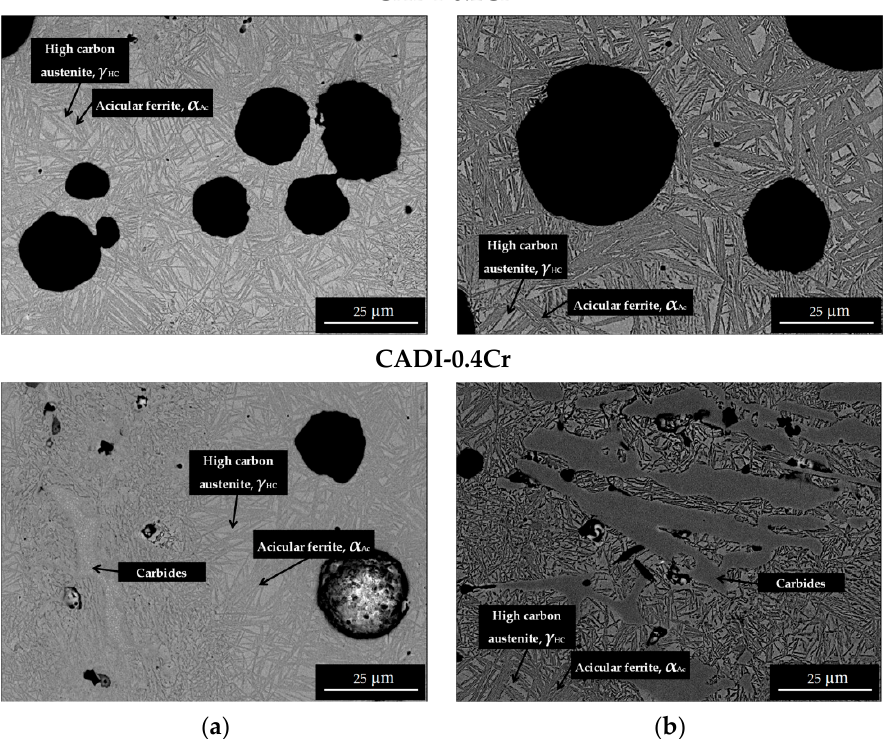
Figure 8. Microstructure of CADI alloyed with 0.2 and 0.4 wt% Cr heat-treated to ( a ) 265 °C and ( b ) 305 °C for 90 min.